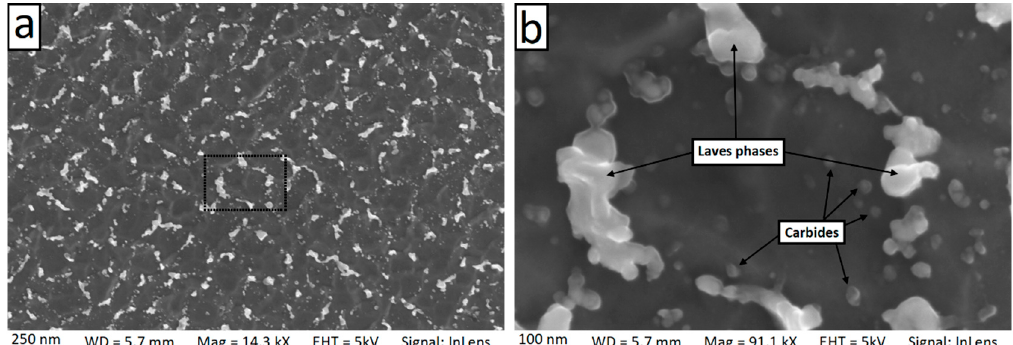
Figure 13. Scanning electron microscopy (SEM) micrographs showing the cellular microstructure on the horizontal plane ( a ) and high magnification view of a single dendrite ( b ).